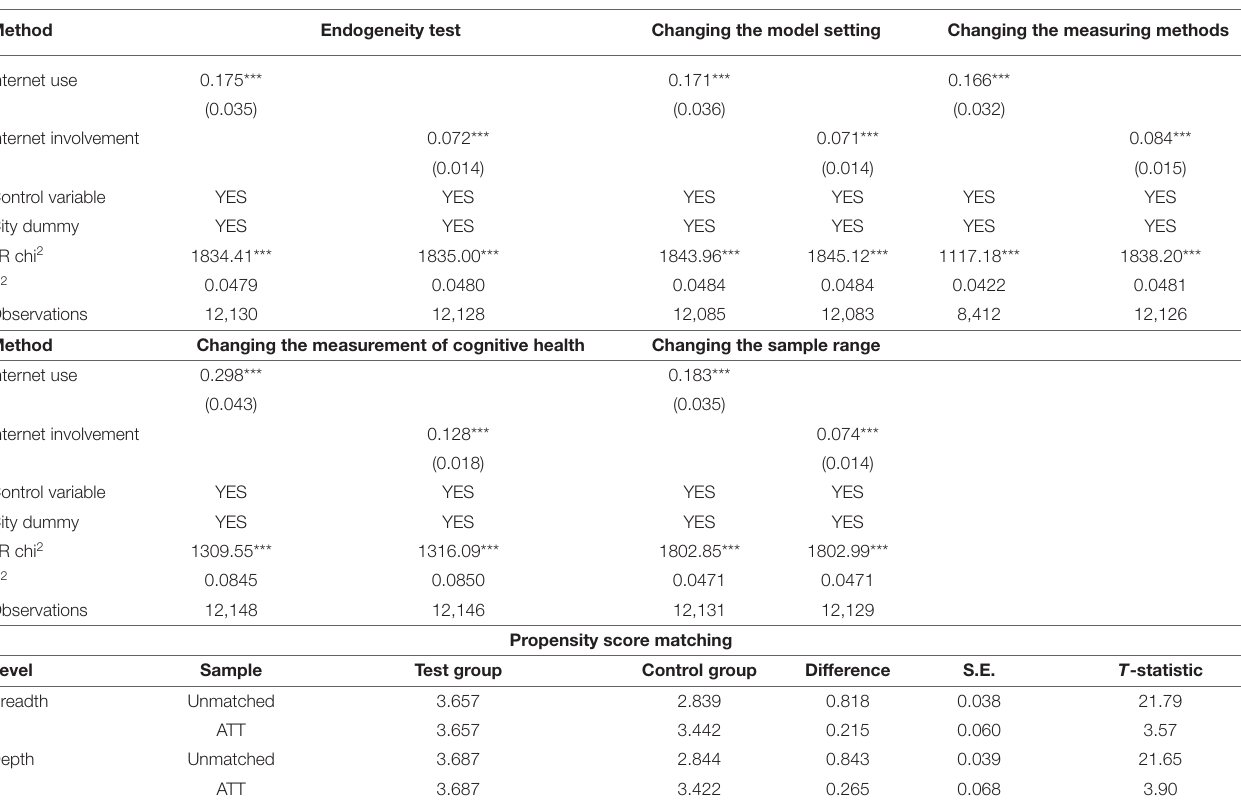
TABLE 3 | Results of robustness